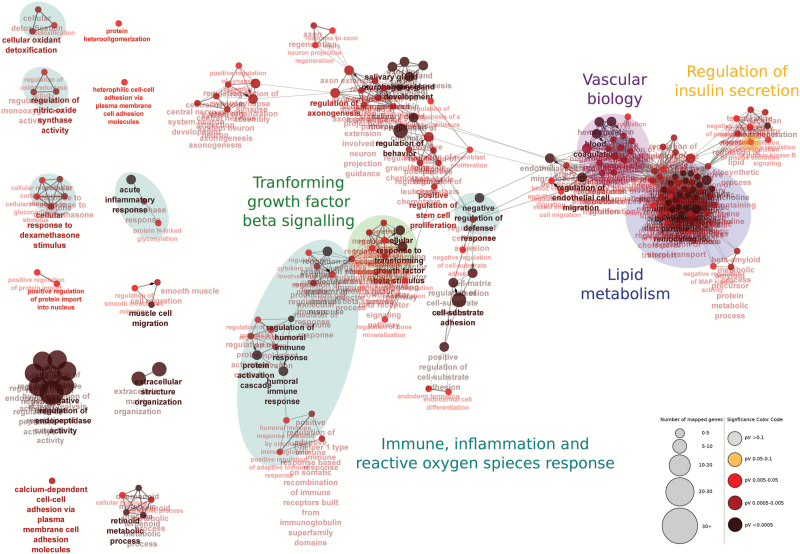
Statistically overrepresented Gene Ontology GO (GO) biological processes identified for the 155 encoded proteins with a signal peptide using ClueGO v2.2.3 in Cytoscape v3.2.1 (32). The network is comprised of nodes presenting significantly overrepresented GO biological processes (p < .05) connected via edges representing overlap between target genes in the overrepresented processes. The colors of the nodes represent the significance of the overrepresentation based on the p‐value and the size of the nodes represents the number of target genes. To aid visual interpretation, related biological processes were manually grouped in clusters indicated by the colored circles. These included vascular biology (purple), regulation of insulin secretion (orange), lipid metabolism (dark blue), transforming growth factor-beta signaling (green) and immune, inflammation, and reactive oxygen species response (light blue).